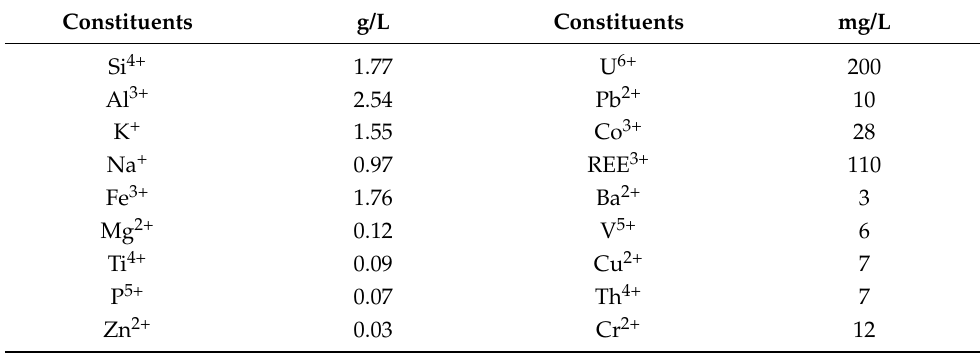
Table 6. Chemical constituents of El Sela leach